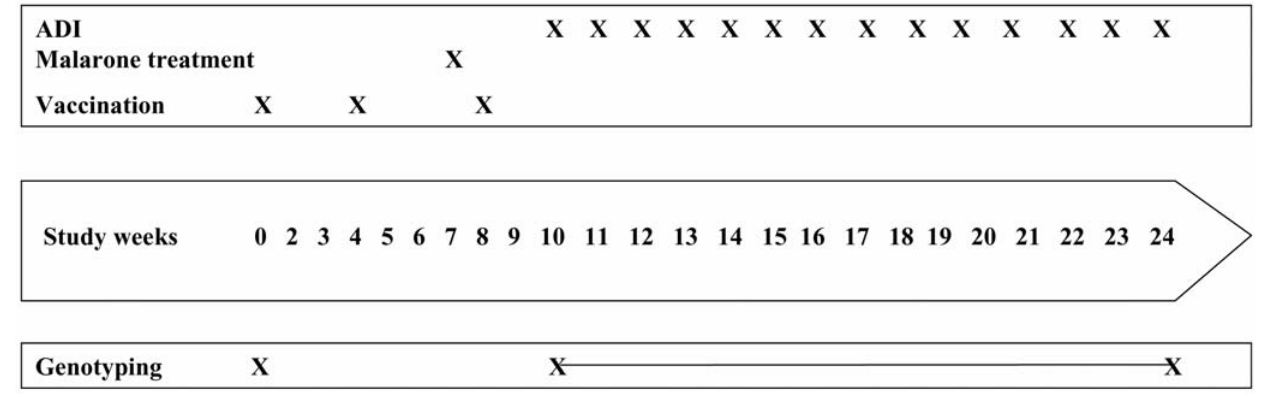
Figure 1. Study events for RTS,S clinical trial in semi-immune adults in Kombewa, Nyanza Province, Western Kenya. ADI=active detection of infection. The ADI period was 14 weeks and began 2 weeks after the third